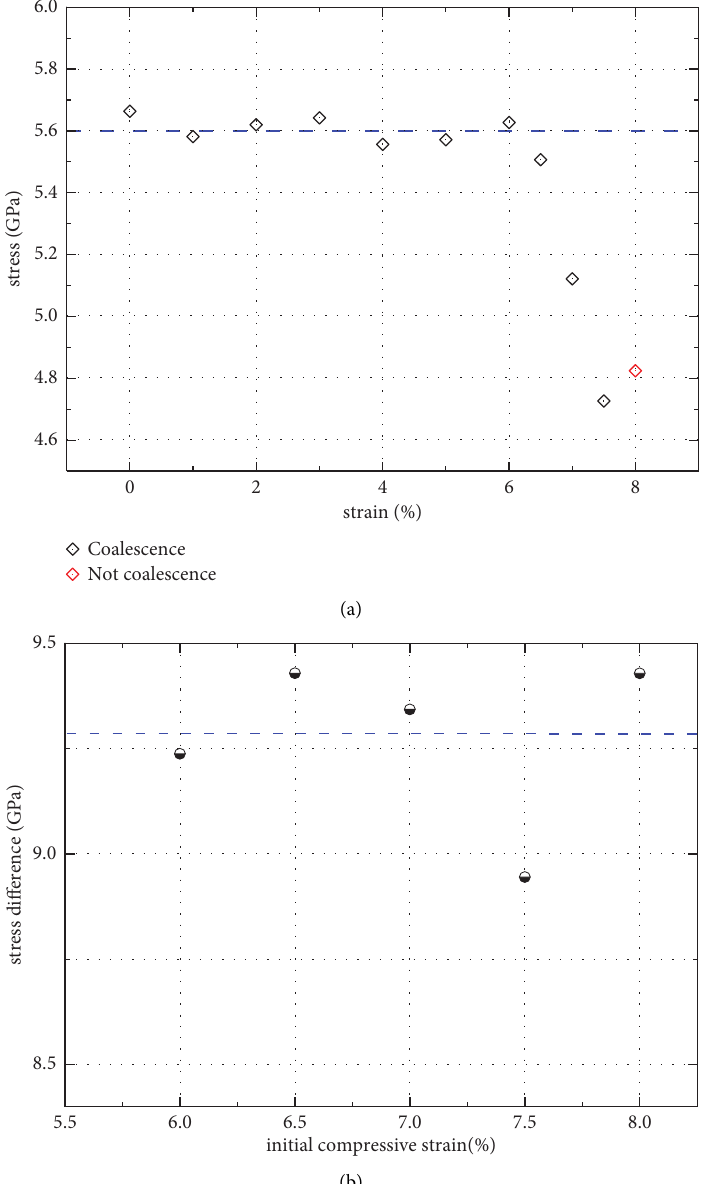
Figure 6: (a) Initial compressive strain vs. yield stress; (b) the relationship between the stress difference and compressive